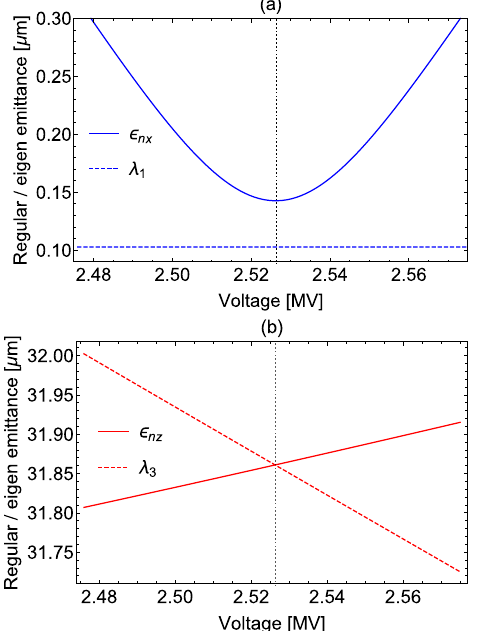
FIG. 5. (a) Transverse and (b) longitudinal emittances and corresponding eigenemittances as functions of the voltage in TCAV4. The dotted vertical line shows the optimal voltage at the minimum of the transverse emittance, which occurs when the longitudinal regular and eigenemittances match.